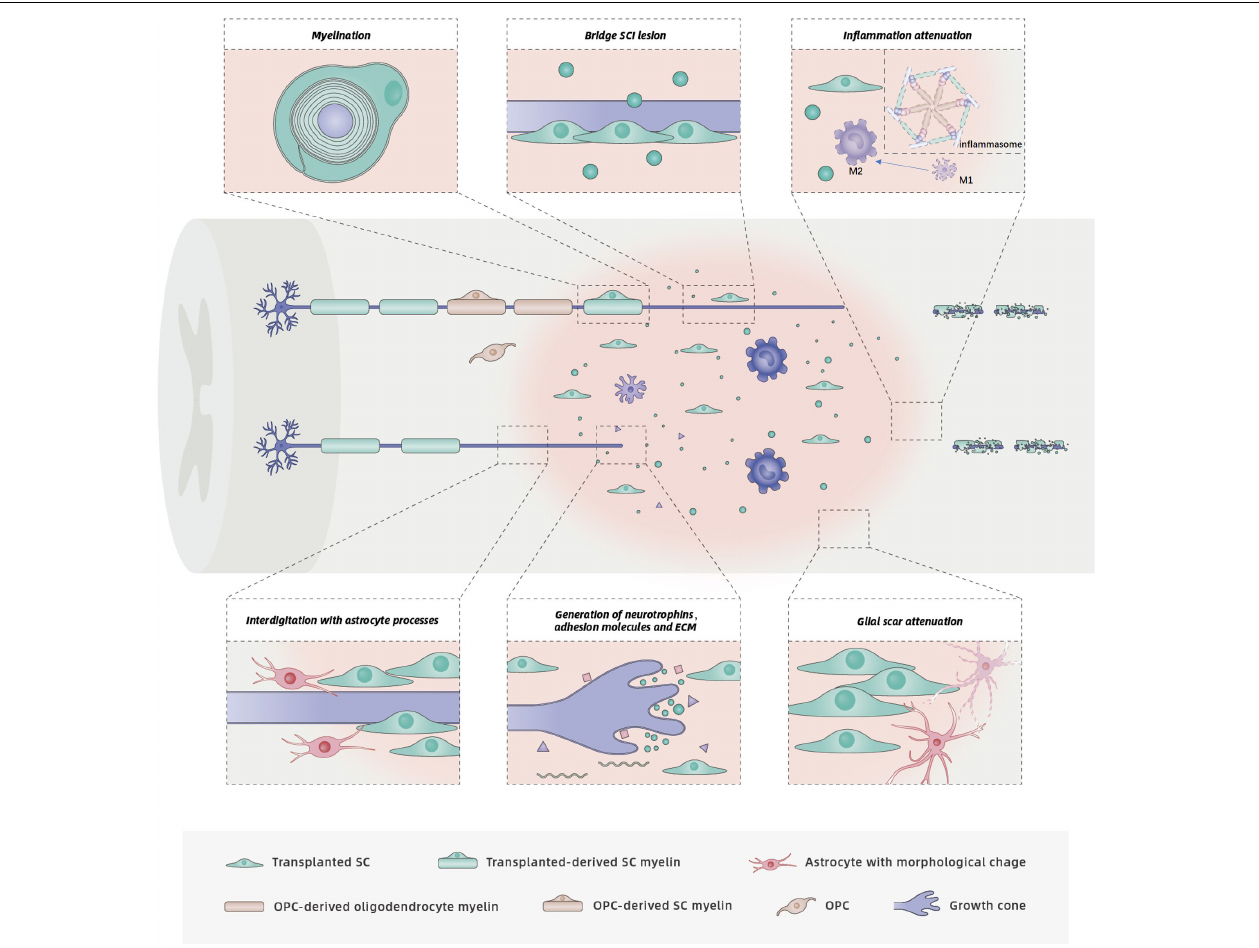
FIGURE 3 | Functions and mechanisms of SCs in SCI repair. The injured spinal cord schematic illustrates potential benefits of SC transplantation, including support of axon growth, remyelination, glial scar attenuation, and related inflammation attenuation. Neurotrophins secreted by SCs bind to specific receptors on axons, which promotes axon regrowth. Although astrocytes prevent SC migration, survival and integration into the normal white matter, the interdigitation of SCs with astrocyte processes has also been observed. The interdigitation of transplanted SC processes with astrocyte processes at the rostral host spinal cord/SC bridge interface results in entry of regenerated axons to the SC bridge. Transplanted SCs form new myelin sheaths around regenerated or spared demyelinated axons. Endogenous OPCs in the spinal cord may differentiate into new oligodendrocytes and PNS-like SCs, both of which produce myelin sheaths. Transplanted SCs also exert neuroprotection by modulating related